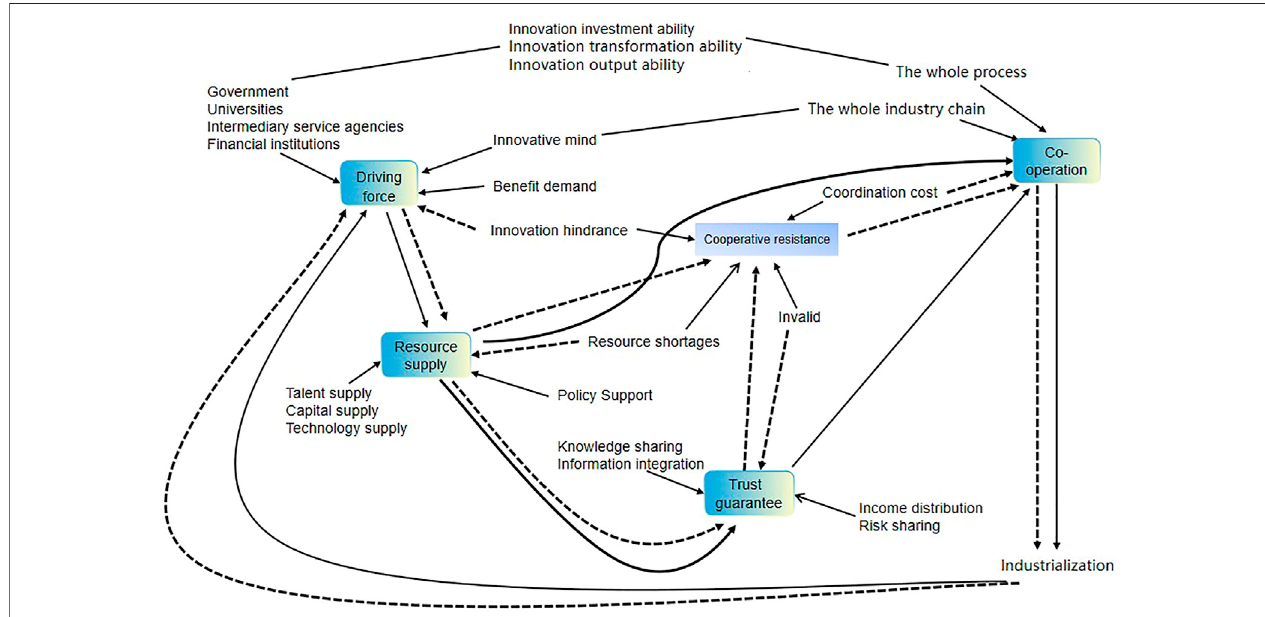
FIGURE 7 | The positive loop and negative loop in the collaborative development of